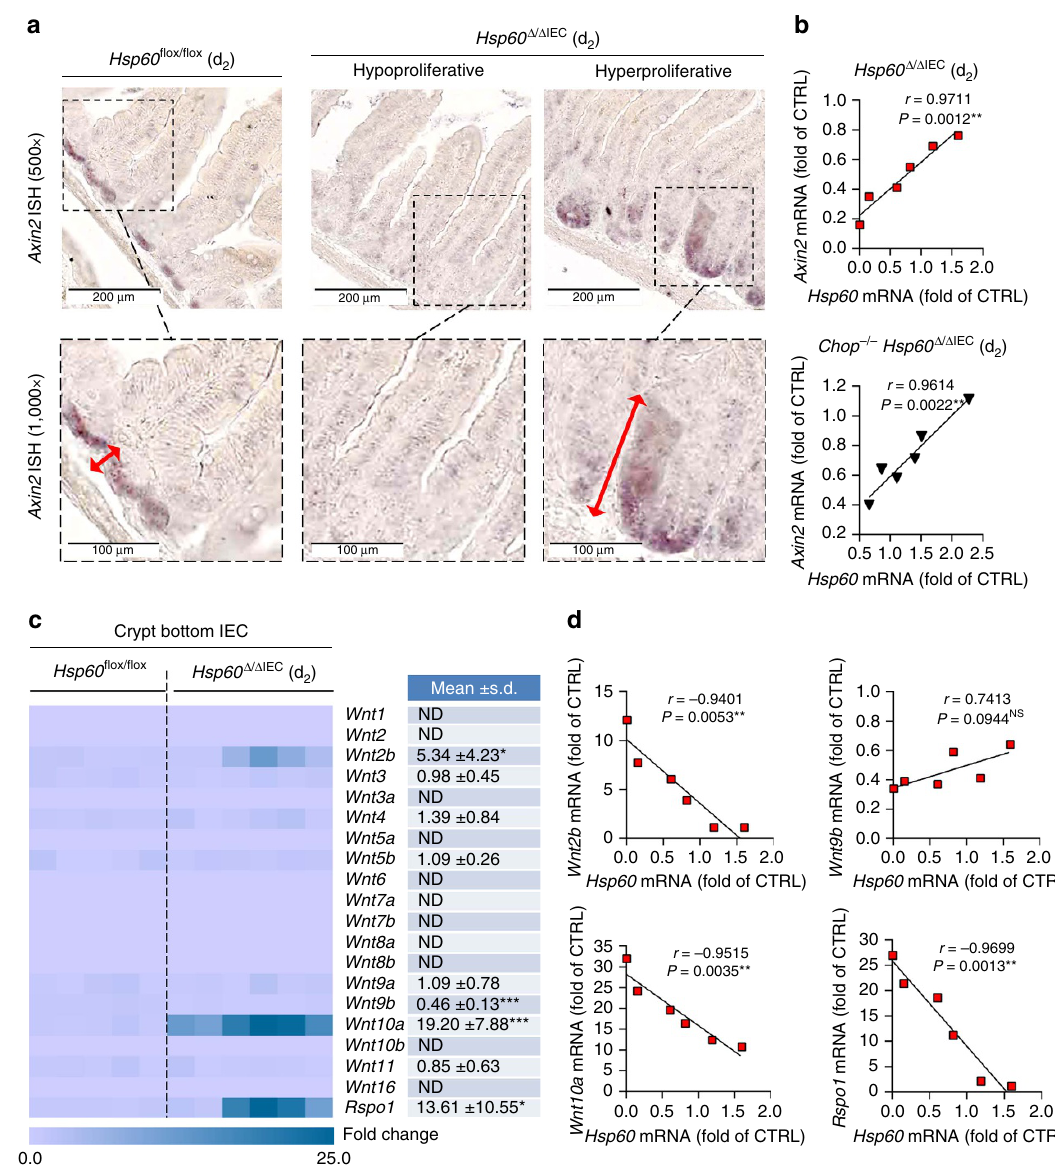
Figure 7 | Stem cell hyperproliferation is associated with epithelial induction of WNT-related signals. ( a ) Representative pictures of in situ hybridization for WNT-target gene Axin2 mRNA in jejunal sections at d 2 including detailed images in higher magnification (red arrows indicate zones of Axin2 expression) ( b ) Correlation analysis (Pearson) of Axin2 and Hsp60 mRNA expression levels in IEC isolated from the crypt of Hsp60 D / D IEC (upper graph) and Chop (cid:2) / (cid:2) Hsp60 D / D IEC (lower graph) mice ( N ¼ 6). P values indicate one-sided significance. ( c ) qRT–PCR analysis of WNT ligands including the WNT enhancer Rspo1 in IEC isolated from the crypt bottom of Hsp60 D / D IEC mice ( N ¼ 6) versus Hsp60 flox /flox control mice ( N ¼ 5). Statistical analyses were performed using unpaired t -tests. ( d ) Correlation analysis (Pearson) of significantly regulated WNT factors with Hsp60 levels in Hsp60 D / D IEC mice ( N ¼ 6). P values indicate one-sided significance. Asterisks indicate significant differences * P o 0.05, ** P o 0.01, *** P o 0.001; NS, not significant; ND, not